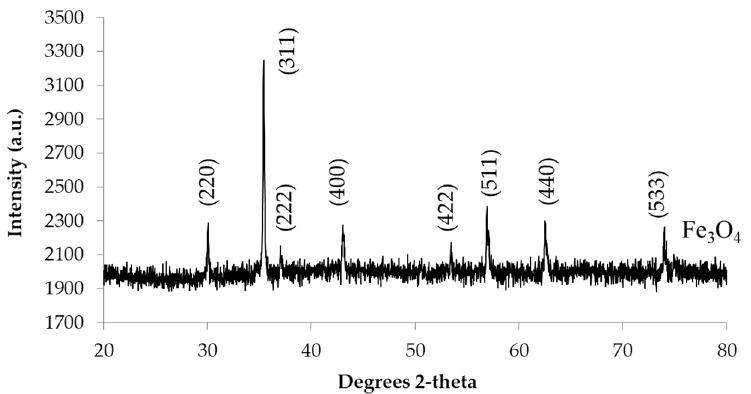
Figure 3. X-ray image of the studied Fe 3 O 4 particles.